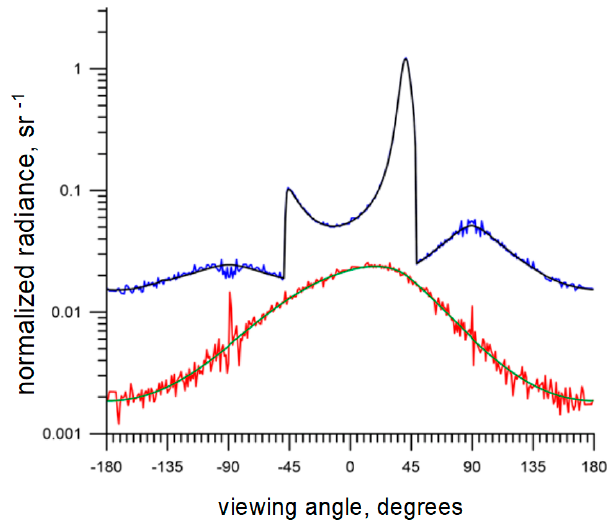
Figure 18. Comparison between the radiance calculation results by Monte Carlo and discrete ordinate methods. Coccolithophore concentration 5 · 10 6 cell / L, wavelength 410 nm, depths 0 − and 4 m. Red and methods. Coccolithophore concentration 5 ⋅ 10 6 cell/L, wavelength 410 nm, depths 0 - and 4 m. Red and blue lines present the Monte Carlo results; black and green, matrix operator blue lines present the Monte Carlo results; black and green, matrix operator method.